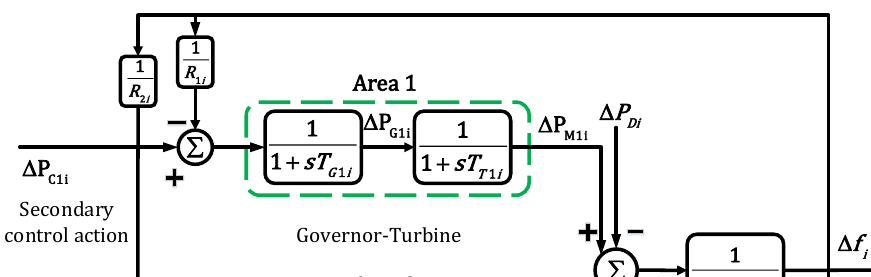
Figure 14. Single-line diagram of 39-bus New England with two areas.